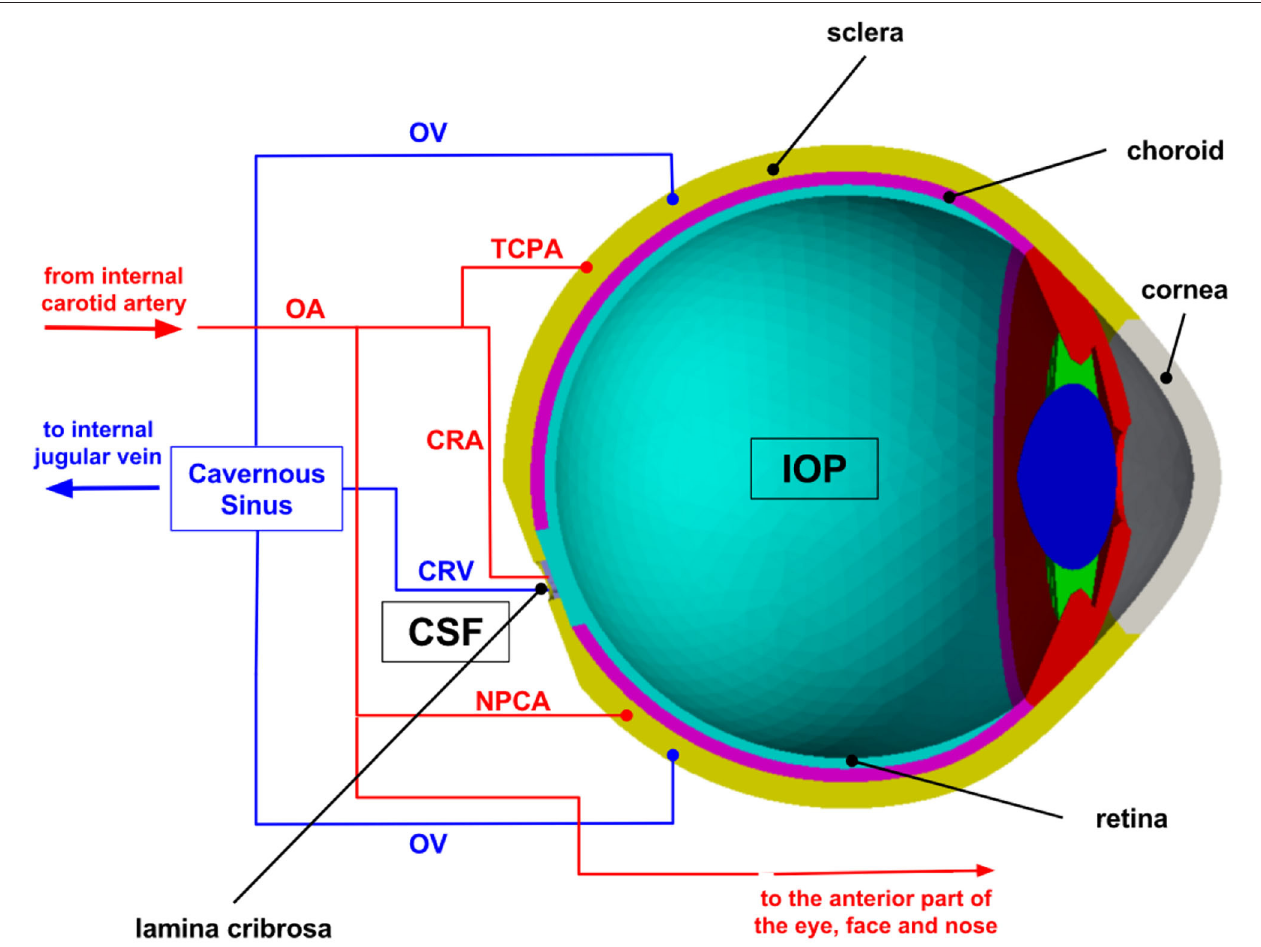
FIGURE 2 | Schematic overview of the multiscale modeling framework implemented in the Ocular Mathematical Virtual Simulator (OMVS). Image reproduced from Sala et al. (2018a), with permission. OA, ophthalmic artery; OV, ophthalmic vein; CRA, central retinal artery; CRV, central retinal vein; NPCA, nasal posterior ciliary artery; TPCA, temporal posterior ciliary artery; IOP, intraocular pressure; CSF, cerebrospinal fluid.